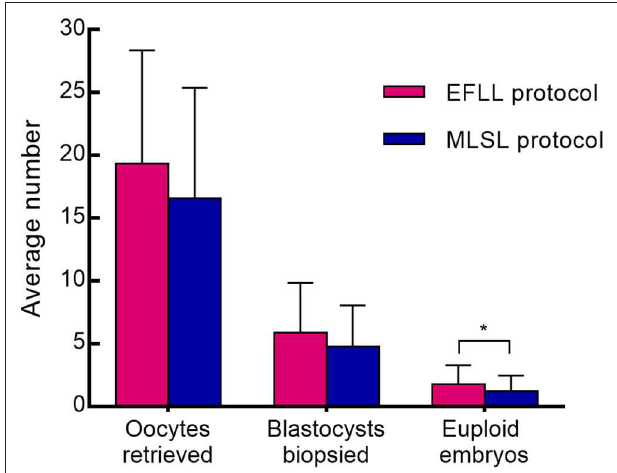
FIGURE 1 | Oocytes retrieved, blastocysts biopsied, and embryos between EFLL and MLSL protocol for PGT-SR. Oocytes retrieved, blastocysts biopsied, and embryos diagnosed as being chromosomally euploidy from patients who underwent PGT-SR cycles using the EFLL protocol and the MLSL protocol, respectively. Values are presented as mean ± standard deviation. * p < 0.05.